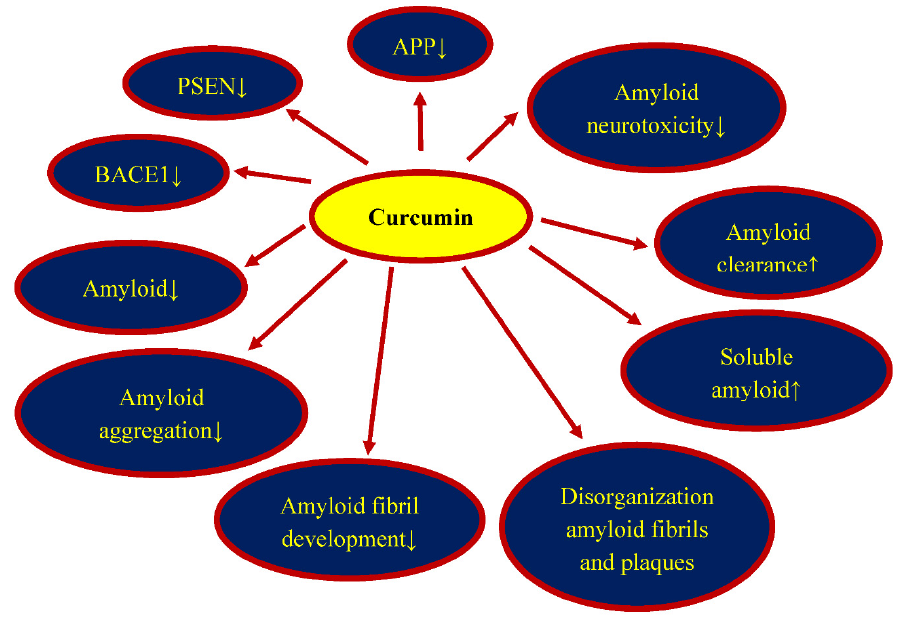
Figure 3. Protective effects of curcumin on post-ischemic amyloid pathology. APP-amyloid protein precursor, PSEN1-presenilin 1, BACE1- β -secretase, ↓ —decrease, ↑ —increase.